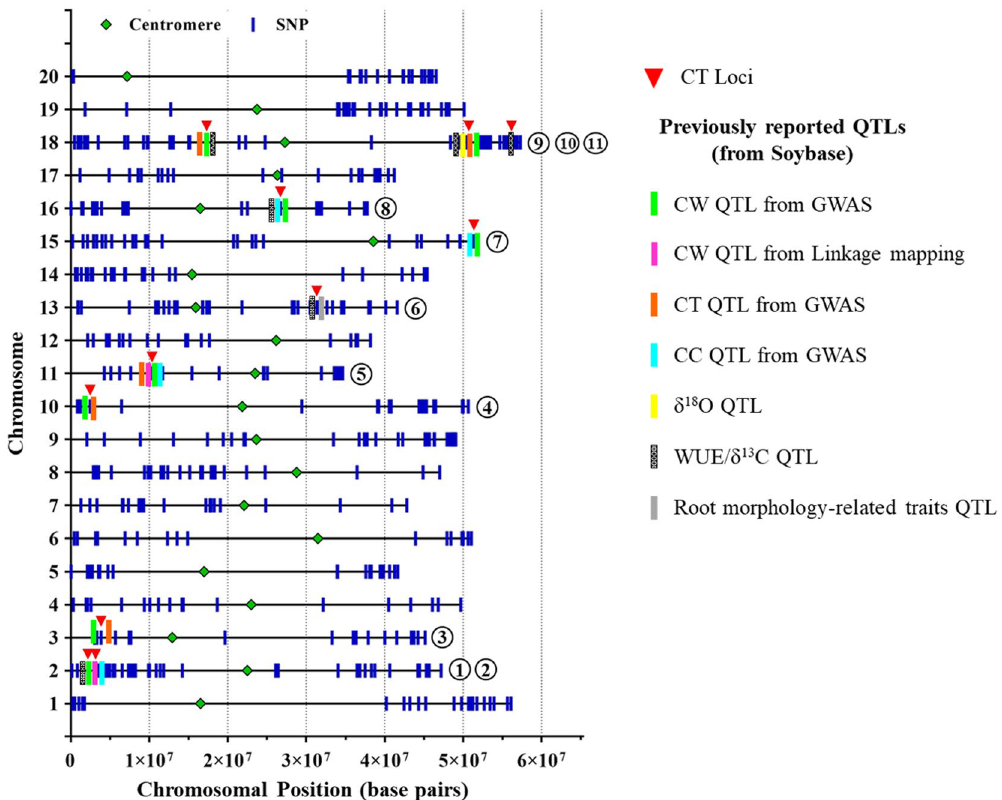
Figure 2. Physical position of SNPs on soybean chromosomes and position of loci (red downward triangle) associated with CT. The numbers in the black circles represent the loci number on a specific chromosome. Vertical colored bars (except blue) indicate the other QTLs found at the same positions in previous studies. CW and CT denote canopy wilting and canopy temperature,